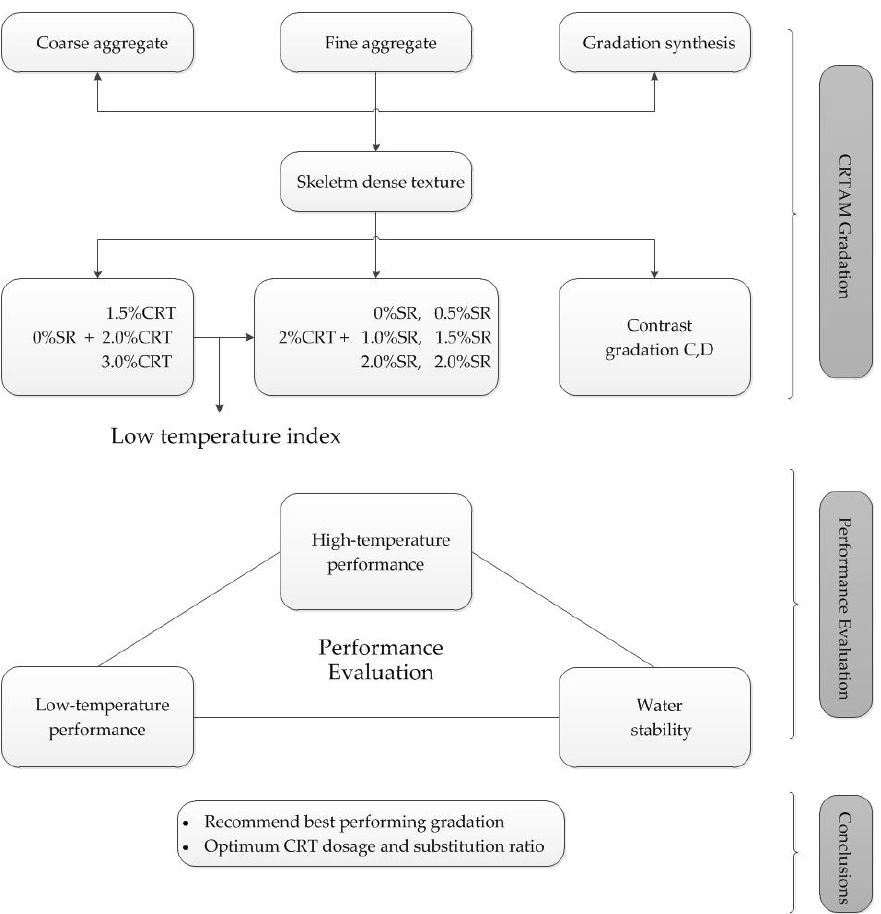
Figure 1. Research framework.